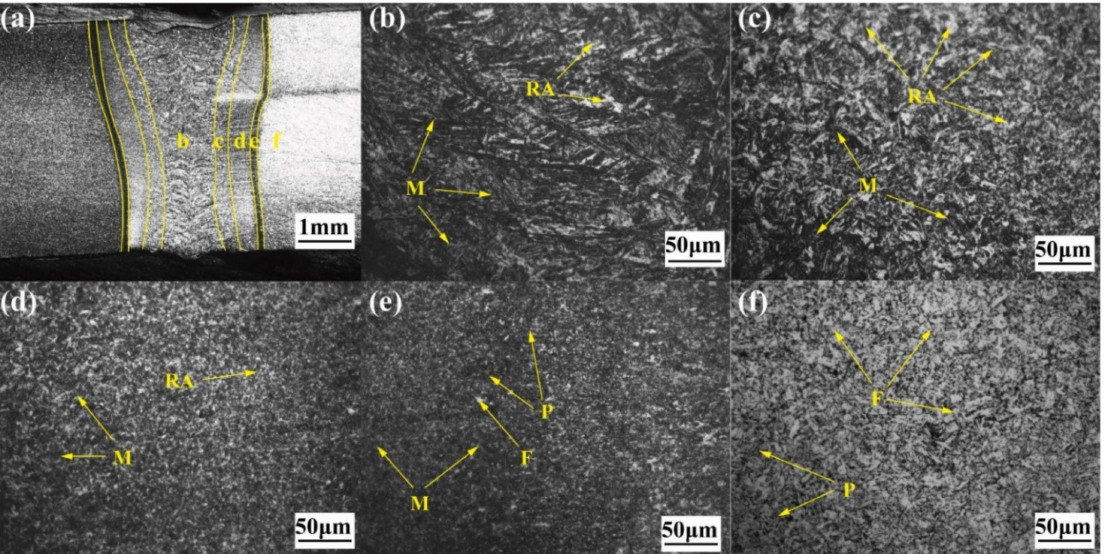
Figure 14. Microstructure of sample No.4 # before quenching: ( a ) macro morphology; ( b ) FZ; ( c ) CGZ; ( d ) FGZ; ( e ) IRZ; ( f ) BM.